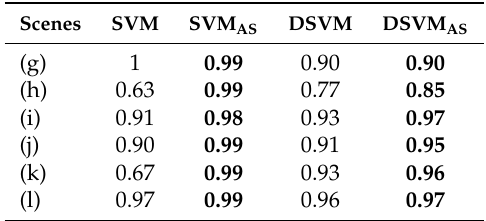
Table 8. F 1 score for the 800 × 800 resolution scenes. The bold values simply indicate the maximum F 1 score.